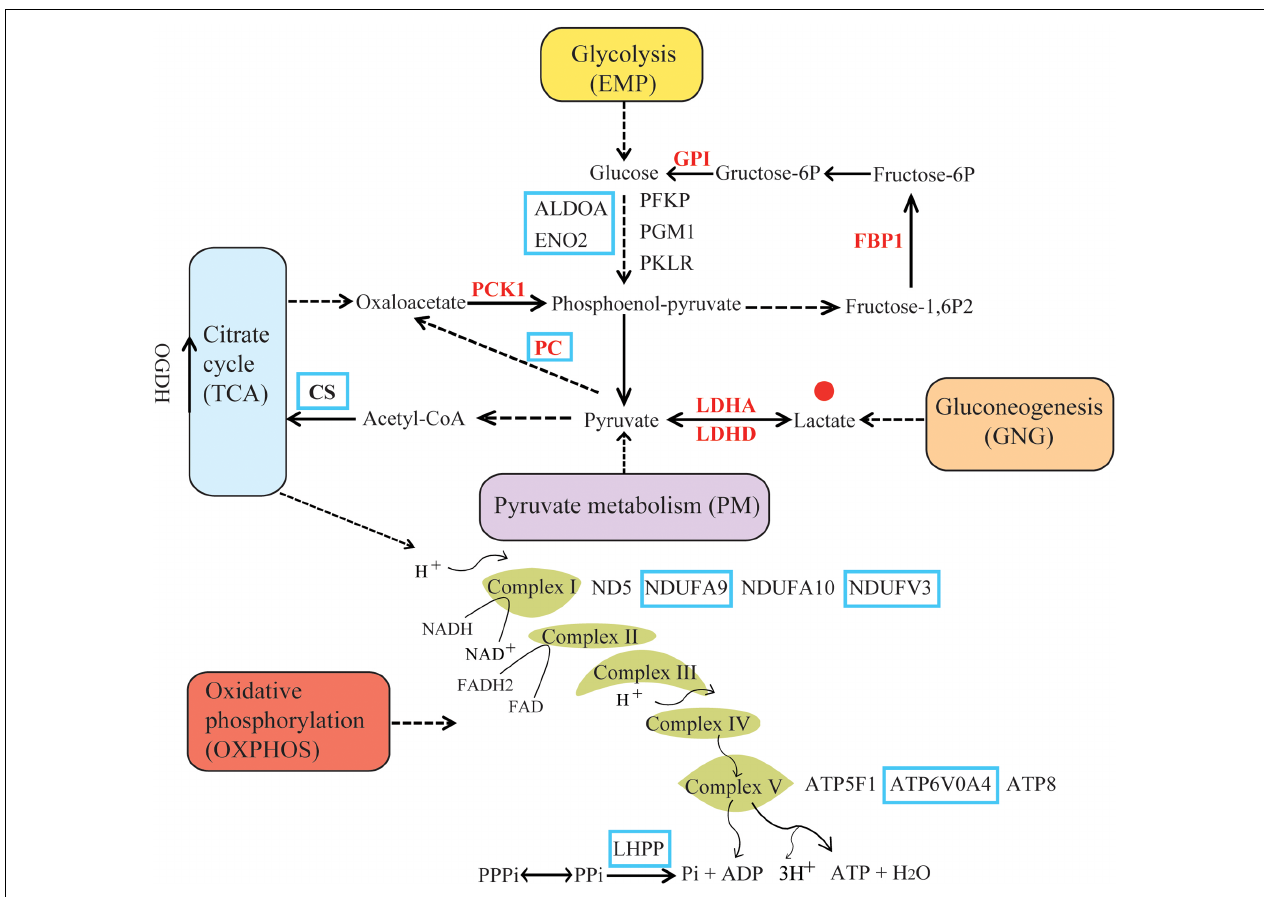
FIGURE 1 | Summary diagram of energy metabolism pathway. Pathway categories were obtained from KEGG. Positively selected genes (PSGs) identified in hypoxia-tolerant mammals are shown in red. The solid lines indicate direct relationships between enzymes and metabolites. The dashed lines indicate that more than one step is involved in a process. Glycolysis (EMP) metabolizes glucose to pyruvate, which provides the cell with ATP under anaerobic conditions (Fromm and Hargrove, 2012). In contrast, gluconeogenesis (GNG) drives the synthesis of D-glucose from non-carbohydrate sources (e.g., lactate), and some glycolytic enzymes are part of the gluconeogenesis pathway. In the pyruvate metabolism (PM) pathway, pyruvate is processed anaerobically (fermented) to lactate (lactic acid fermentation) or ethanol (alcoholic fermentation), and can be aerobically oxidized to CO 2 . Of note, lactate and pyruvate is either the product of EMP or the